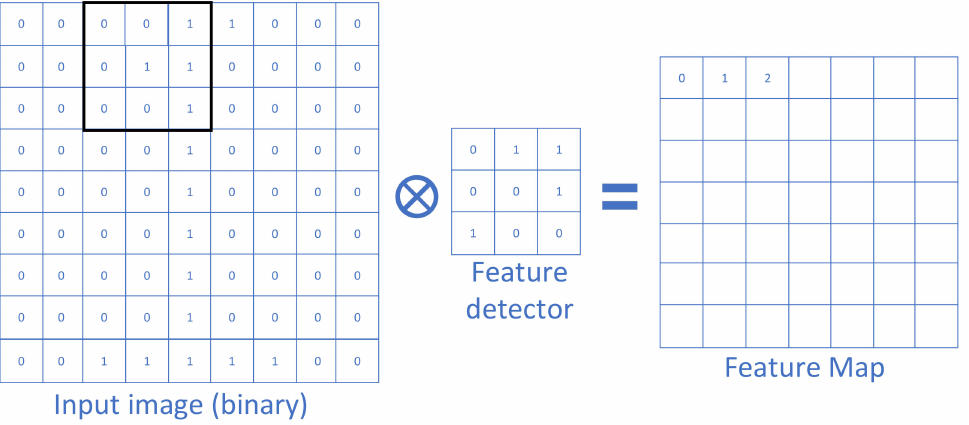
Figure 3. Binary conversion of feature map